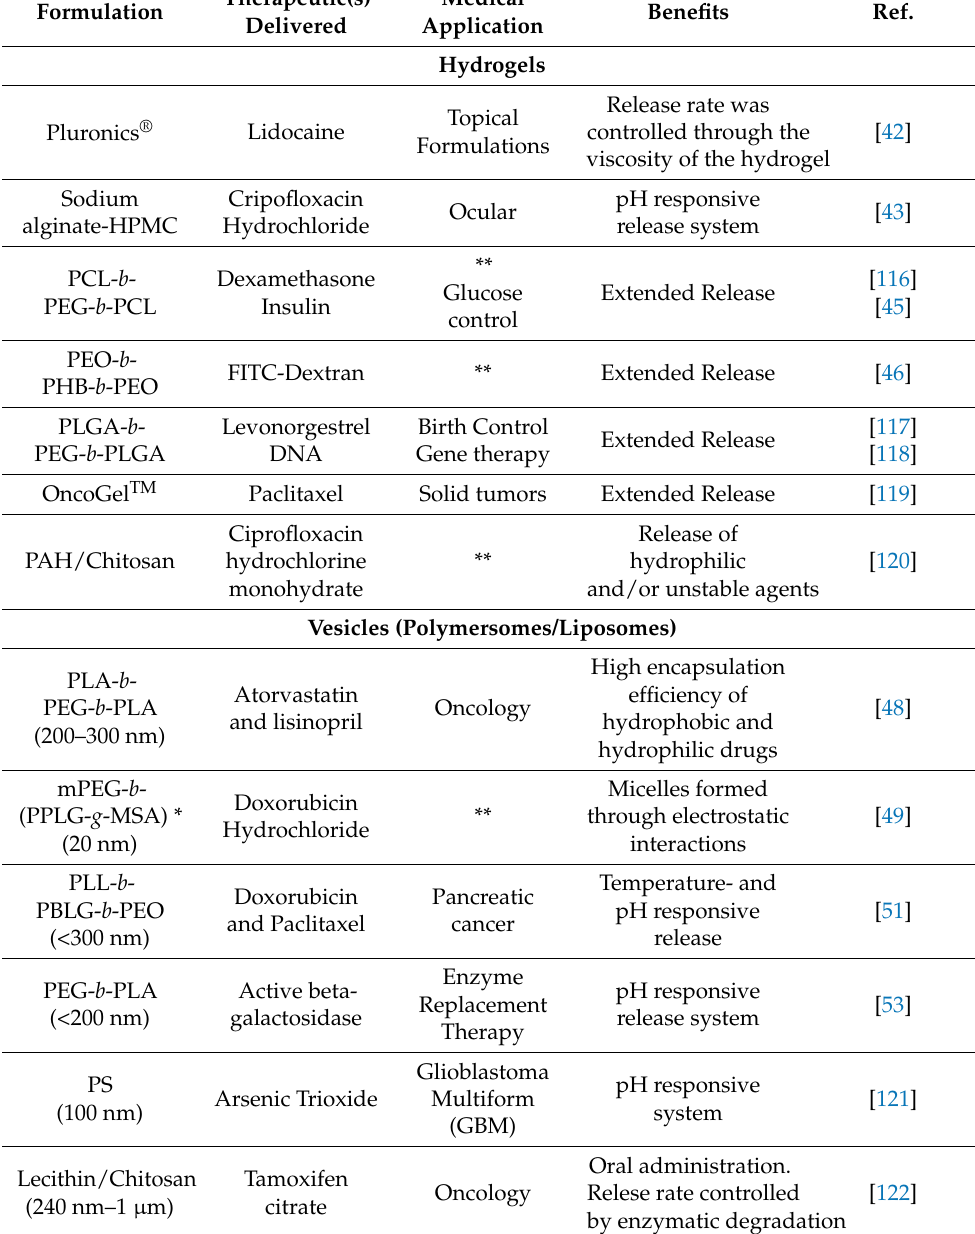
Table 2. Cont. Formulation